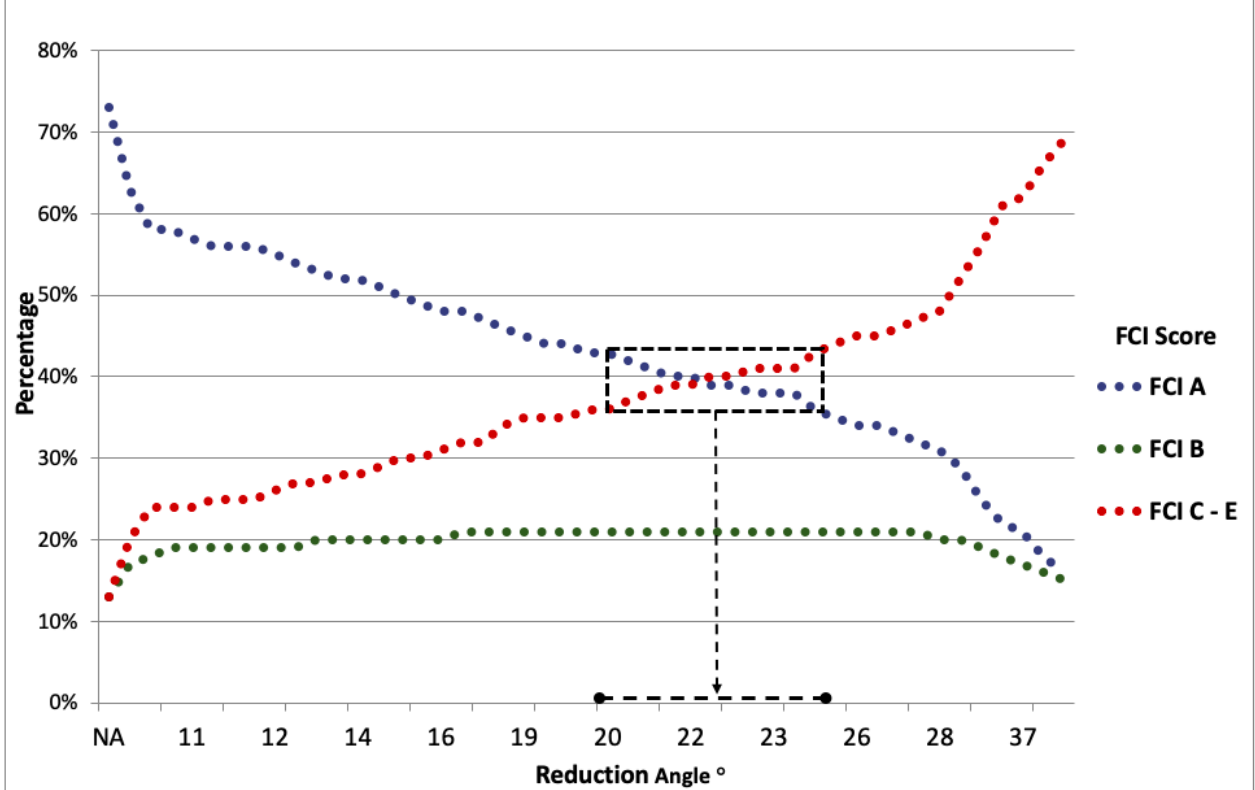
Figure 3. Ordinal regression of the reduction angle (RA) and probability graph for the development of hip laxity in dogs. The dotted blue, green, and red lines represent the probability for the development of category HD A, HD B, and HD C–E hips, respectively. The black square marks the zone in which the probability for category HD A and category HD C–E is between 36% and 43%. In this zone, the RA ranges from 20° to 25°. NA = not available.